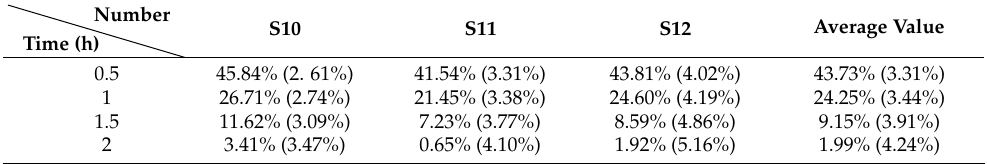
Table 5. Relationship between moisture content, fissure rate and time of the improved